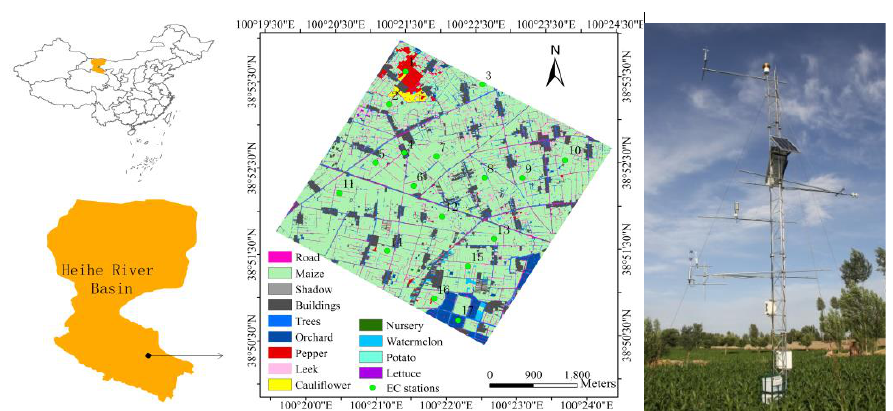
8 of 21 Figure 2. The flow chart of the study (blue dashed frame: improvements of the MOD16 model). To test the model performance of the improvements, ET estimates retrieved by the